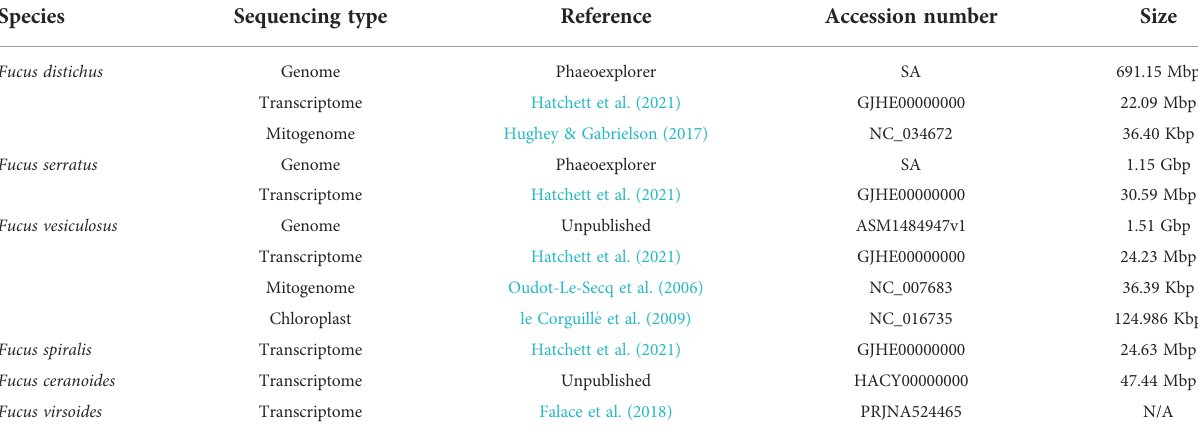
TABLE 2 Current or soon to be available (SA) genomic data for Fucus